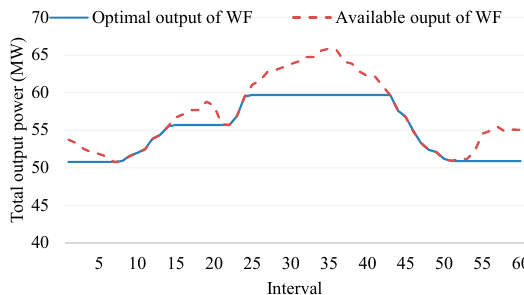
Figure 12. Optimal output power of WF.